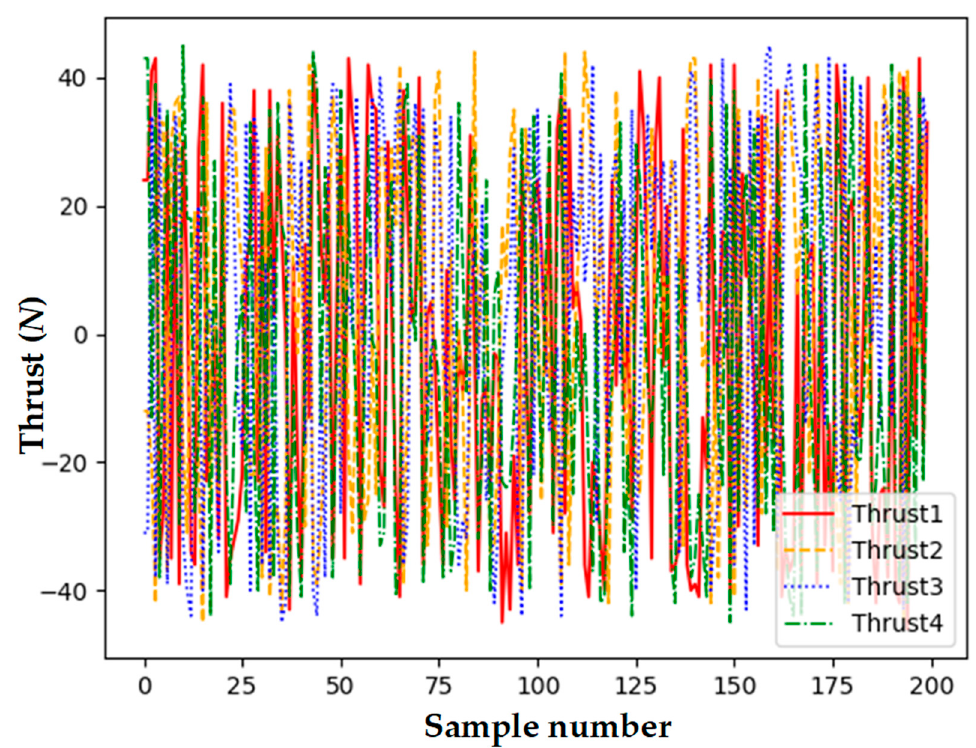
Figure 4. Heading priority thrust distribution results.